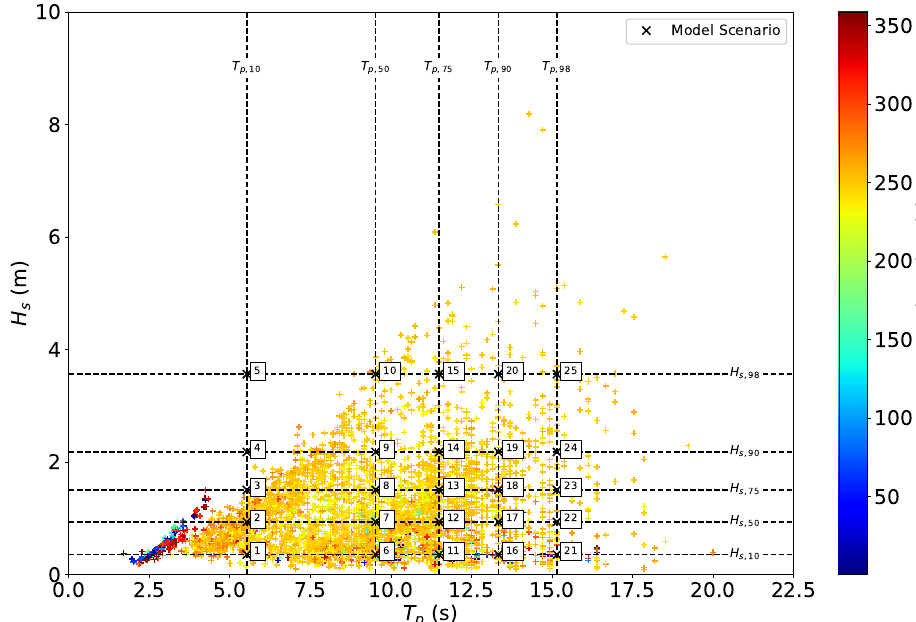
Figure 3. H s and T p values at each high water (Table 2), and the corresponding wave direction. High-water times are obtained from the Milford Haven tide gauge. H s , T p and wave direction data is obtained from the U.K. Met Office WaveWatchIII model